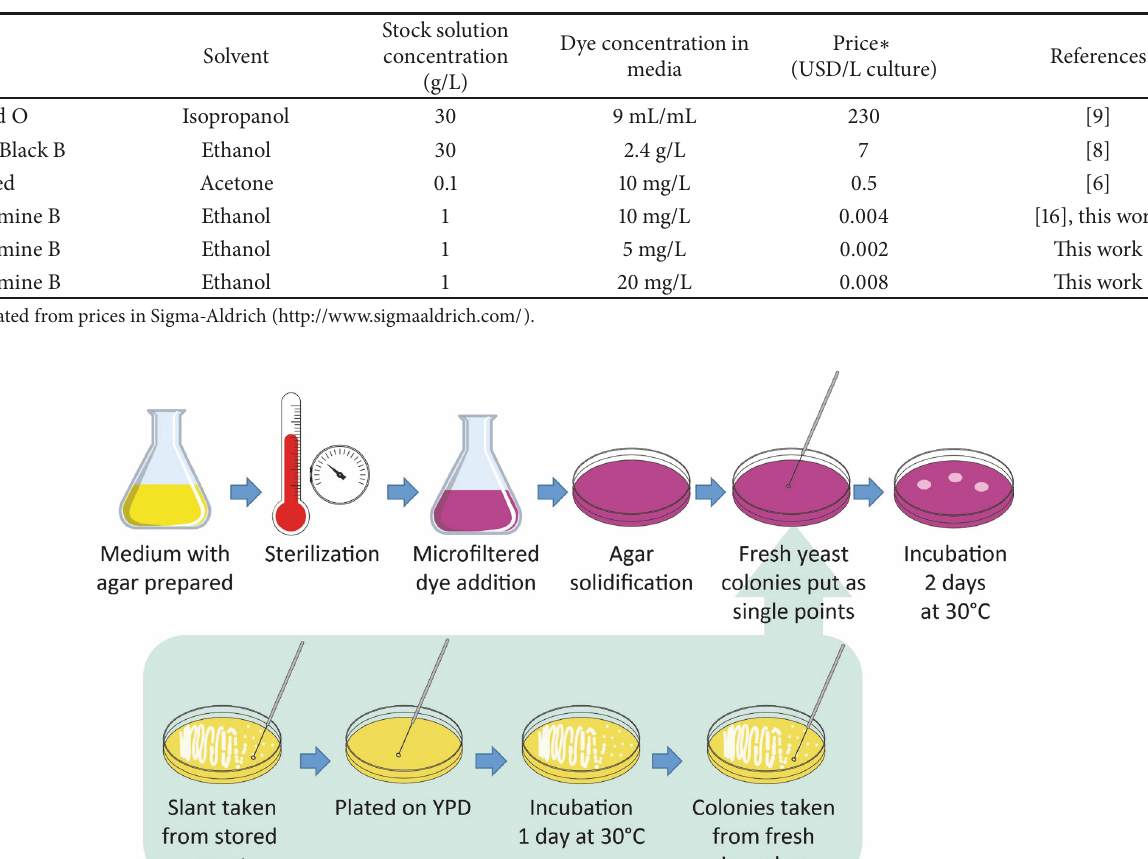
Table 1: Lipid dyes tested for the screening of oleaginous yeasts.